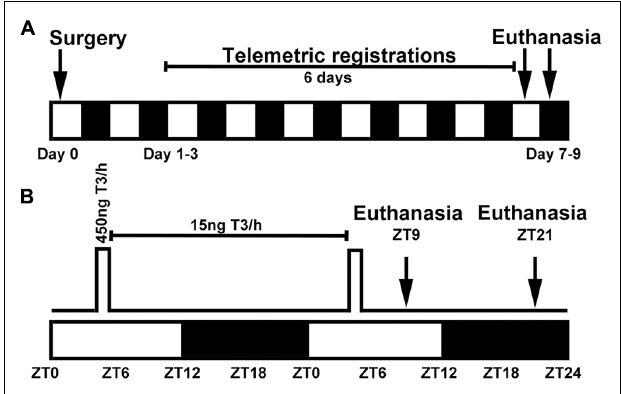
FIGURE 1 | Experimental setup for surgeries and pump settings in circadian oscillating T3 infusions in rats. (A) Surgery was performed on day 0 and included SCN lesion and implantation of a subcutaneous telemetry transmitter and an iPRECIO pump. Telemetric registration of locomotion and body temperature was done for 6 days prior to euthanasia at either ZT9 or ZT21. The study included six experimental groups ( n = 3–5) and a total number 26 animals; 40 animals underwent surgery, but 14 were excluded. (B) Pumps were programmed in 24 h repeat loops with a high T3 infusion rate of 30 µ l/h from ZT4 to ZT5.5 followed by a low maintenance infusion of 1 µ l/h for the remaining 22.5 h. White and black boxes indicate periods of light and darkness,